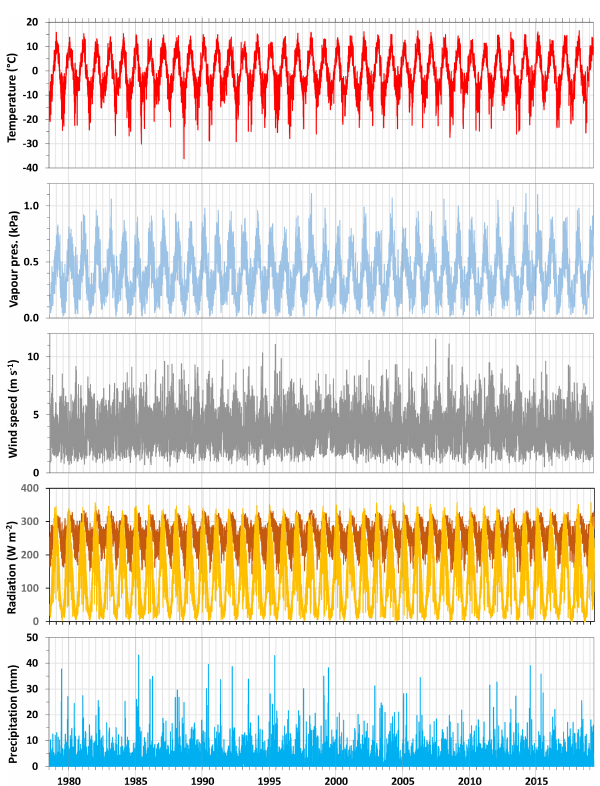
Figure 13. Bias-corrected meteorological forcing data from ERA- Interim. Daily precipitation is the 24h total, and the other data are plotted as 24h means. Yellow and dark orange in the radiation panel, respectively, are incoming shortwave and longwave radia- tion.